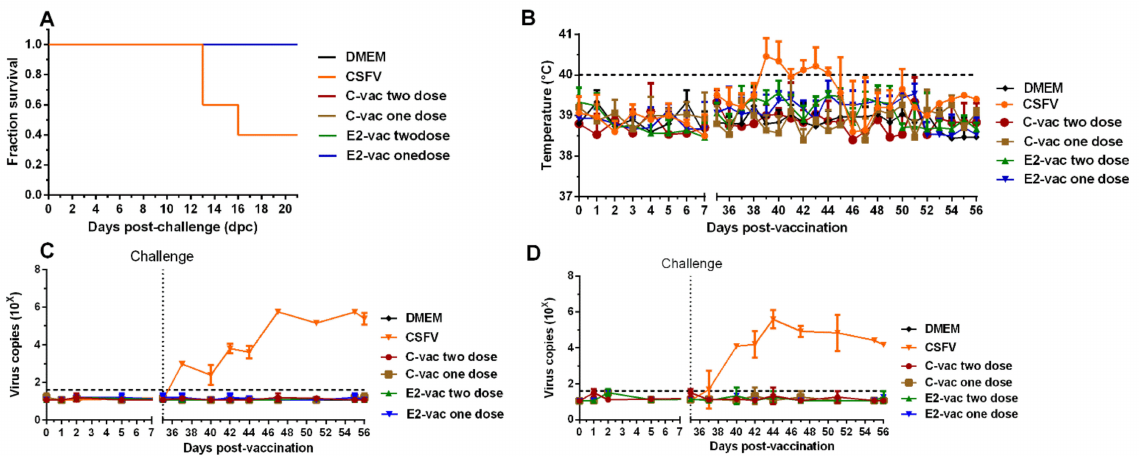
Figure 2. The survival curves, body temperatures, viremia, and virus shedding of the experimental pigs. ( A ) Survival rate, the lines of dates are covered by the lines of DMEM and CSFV data. ( B ) Body temperature. ( C ) Viral copies in oropharyngeal swab samples. ( D ) Viral copies in the blood. The dotted line represents the minimum detection threshold. DMEM: the blank control group that received no immunization and no challenge. CSFV: the infection control group that received no immunization. C-vac one dose and E2-vac one dose: pigs were intramuscularly injected with the relevant vaccines at 23 dpv. C-vac two doses and E2-vac two doses: pigs were intramuscularly injected with the relevant vaccines at 0 dpv and received a booster immunization at 23 dpv. At 35 dpv, pigs in all groups except DMEM group were challenged with